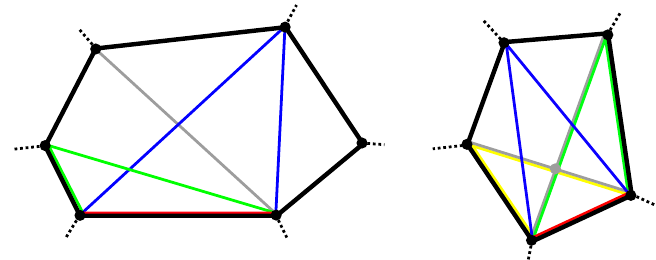
Figure 12 . Illustrative examples of partially triangulated 3-dimensional fans whose intersections with the unit-sphere S 2 are depicted. The hole in the truncated cluster fan is drawn in black. On the left hand side, the hole contains two non-simplicial cones separated by the grey line, representing a tropical hypersurface. The algorithm attempts to complete the faces on the boundary of the hole to simplicial cones. For the red face, two such possible completions are drawn in green and blue. Out of the two, only the green is valid, as the interior of the blue cone intersects the grey tropical hypersurface. On the right hand side we have two intersecting tropical hypersurfaces inside the hole, implying that it contains a valid ray. In this case, the red face cannot be completed to a valid cone by our